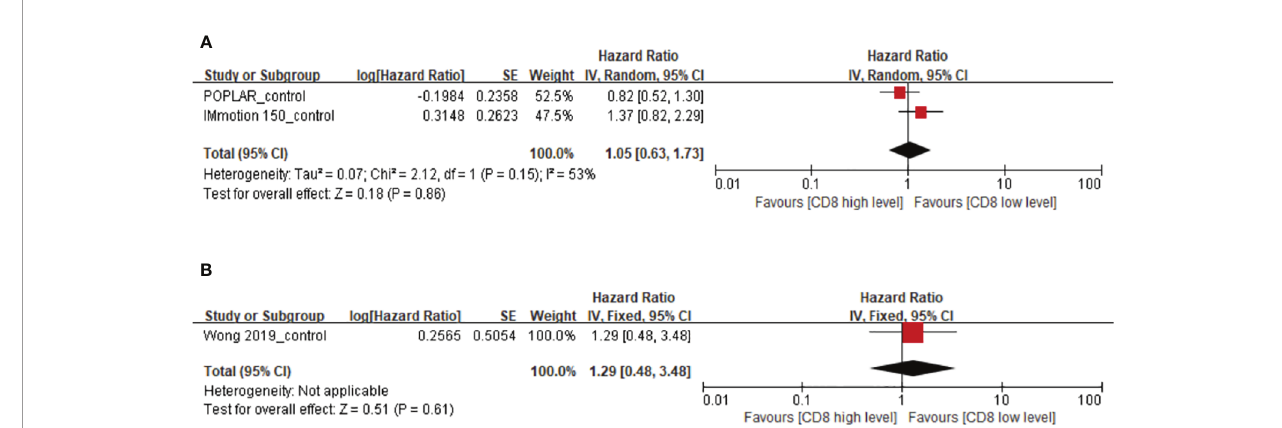
FIGURE 4 | (A) Florest plots of the random-effects meta-analysis for the effects of memory CD8(+) T cells on PFS in cancer patients with non-immunotherapy. (B) Florest plots of the fi xed-effects meta-analysis for the effects of memory CD8(+) T cells on OS in cancer patients with